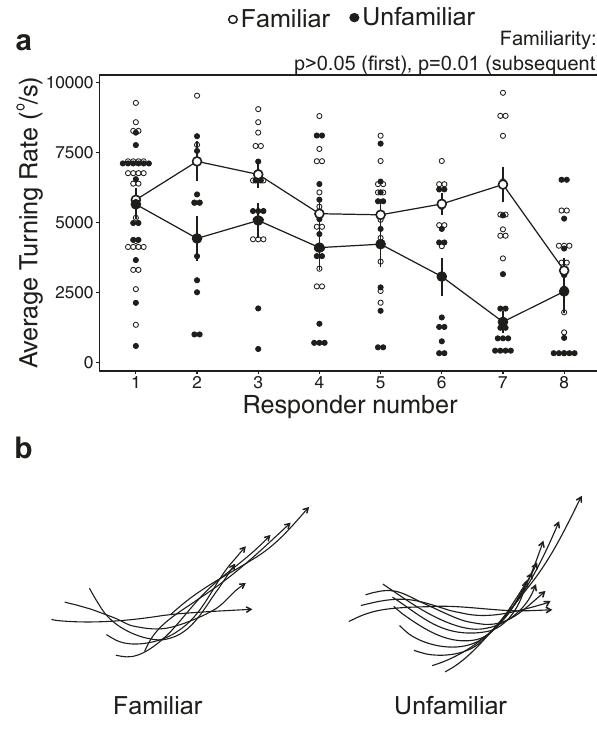
Fig. 3 The average turning rate of the fast-start escape response in familiar versus unfamiliar schools of the damsel fi sh Chromis viridis . a Average turning rate by responder number (which denotes the sequential order of responses in each fi sh ’ s respective group). Each larger dot represents the mean ± s.e., with small dots indicative of individual data points. p -values indicate results of linear mixed-effects model analyses ( n = 24 schools, composed of 8 fi sh each). b Typical escape responses in the familiar (left) and unfamiliar (right) treatments. Lines represent the fi sh midline and arrows indicate the location of the head in successive frames at 4.2 ms intervals. The greater number of lines in the unfamiliar example indicates that the individual took more time to achieve a similar evasive manoeuvre to the individual in the familiar treatment.